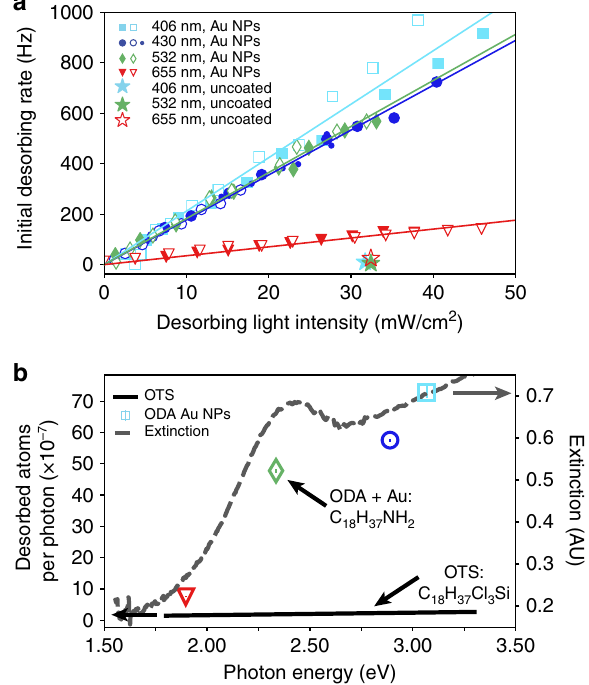
Fig. 4 Rb desorption yield follows the extinction spectrum pro fi le of the Au NPs. a The initial desorption rate of Rb from the walls of the Au NP coated vapor cell exhibits a linear dependence on the desorbing light intensity, for four wavelengths: 406 nm, 430 nm, 532 nm, 655 nm. Cell temperature 17 ° C. Control experiments with the uncoated reference vapor cell (marked with stars) show no increase in desorption upon illumination with light of all four wavelengths. The control experiments were offset from 0 for clarity. Filled and un fi lled data points correspond to data taken on different days. b Calculated yield (Rb desorption per photon) of the desorption process for each wavelength and comparison with calculation for an OTS coated vapor cell from ref. 33 cell temperature 25 °C. Gray dotted line: comparison with Au-capped ODA extinction spectrum as a guide to the eye